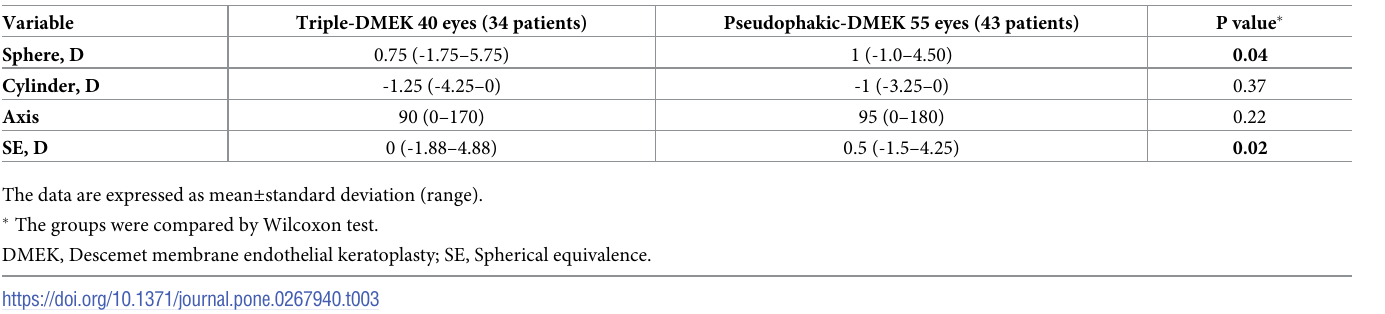
Table 3. Refractive outcomes of the study groups at 12 postoperative